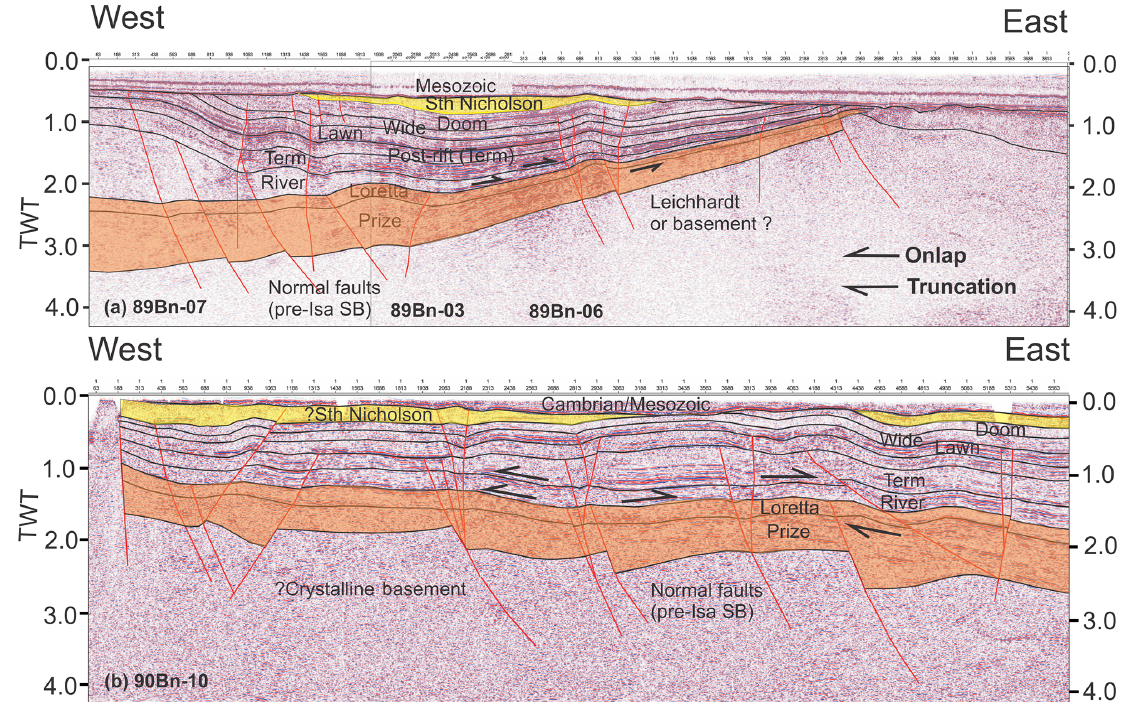
Figure 7. West–east-oriented seismic transects through northern Lawn Hill Platform. Westward thickening of Calvert-age sedimentary units in both (a) and (b) is consistent with growth faulting on east-dipping normal faults which have since been variably reactivated (Isa Orogeny). Conversely, no such growth is obviously developed in the overlying Isa Superbasin, whose lithological strike and inversion structures are essentially parallel to the line of section. These units still thicken into the centre of the Isa Superbasin but in a direction orthogonal to normal faults active during its deposition. Such faults, if imaged, would be expected to be flat-lying or have very shallow dips parallel or subparallel to bedding in both sections, rendering their recognition very difficult. Some of the disruption to bedding in (b) along line 90Bn10 may be due to such faults, but overall the most obvious structural feature in the section is the broad arching and folding of stratigraphy in the middle of the section consistent with imaging of an inversion fold in longitudinal cross section. Note truncated surface and angular unconformity at the base of Loretta Supersequence in both sections which is interpreted here to be an expression of basin inversion linked to the 1650–1640Ma Riversleigh Tectonic